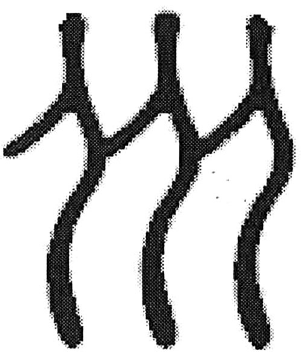
Fig. 5 “ Ren Ren Ren ” trademark of Renmin University of China.